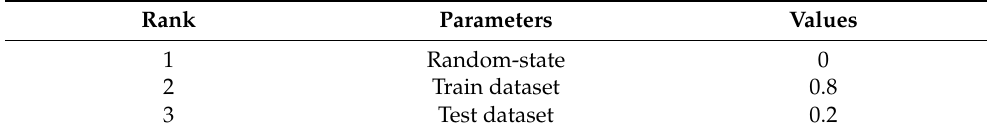
Table 8. The parameters of training model.